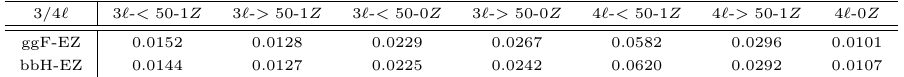
. ( m Φ , m e ) = (1500 , 750) GeV. T 4